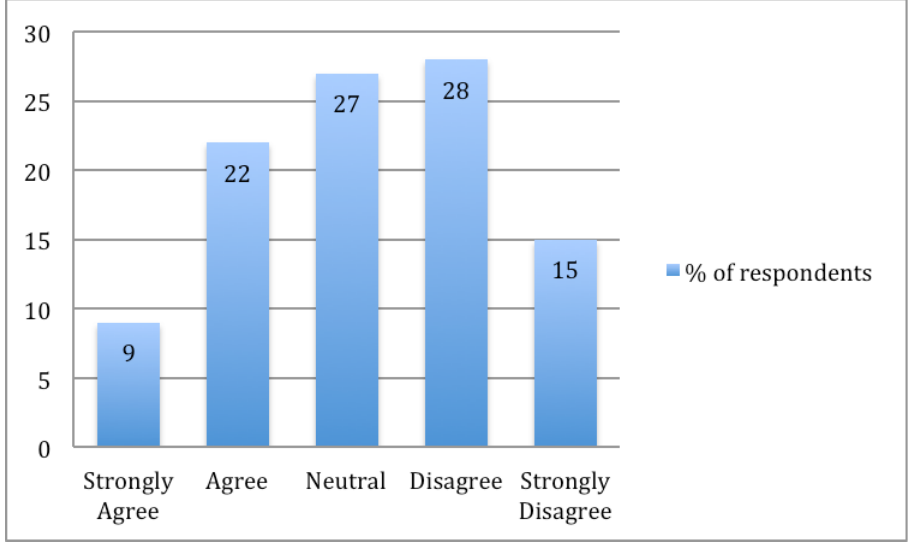
Figure 8. No trust in others'